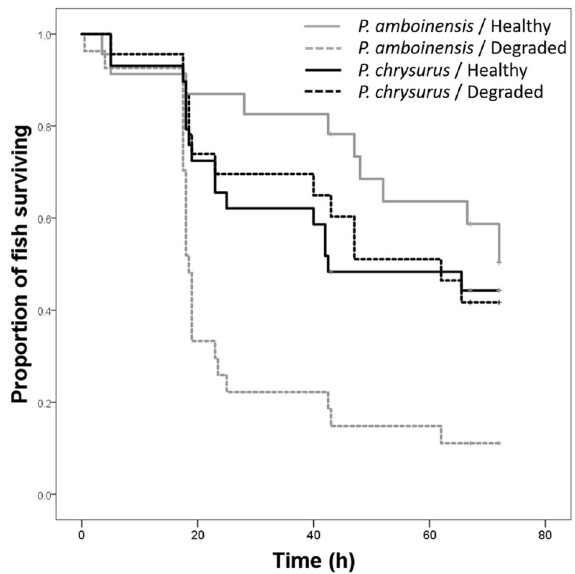
Figure 3. Cumulative proportion of P. amboinensis surviving over time in situ. Prior to deployment in the field, P. amboinensis were taught to recognize three common predators (lizardfish, wrasse and dottyback) using alarm cues from conspecifics ( P. amboinensis , grey lines) or alarm cues from a closely-related heterospecific ( P. chrysurus , black lines). The training took place in water containing cues from either healthy, live (solid lines) or dead-degraded (dashed lines) Pocillopora damicornis